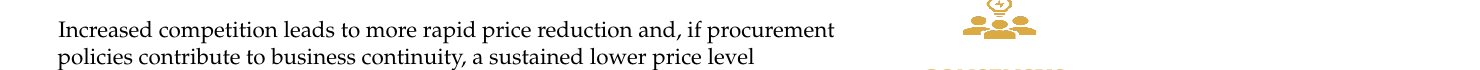
Table 1. Consensus on components of a sustainable biosimilar market.